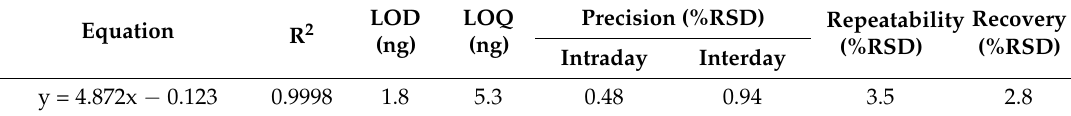
Table 5. Validation parameters of the HPLC method.